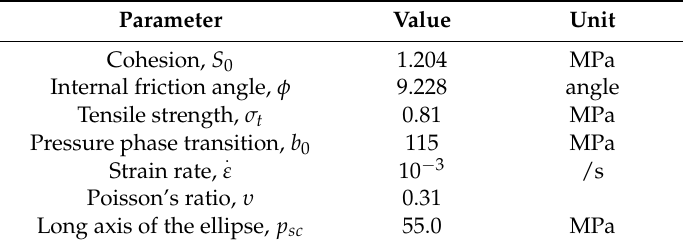
Table 9. Calculated value of each parameter in this